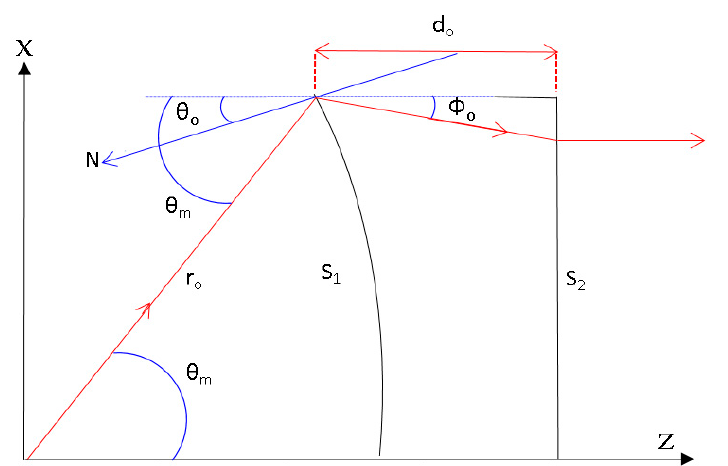
Figure 4 . MATLAB Program . Figure 4. MATLAB Program.